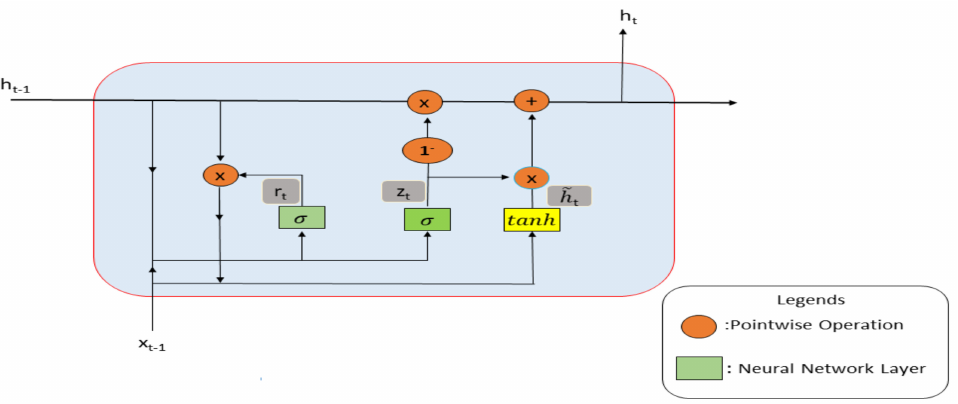
Figure 2. Representation of a GRU